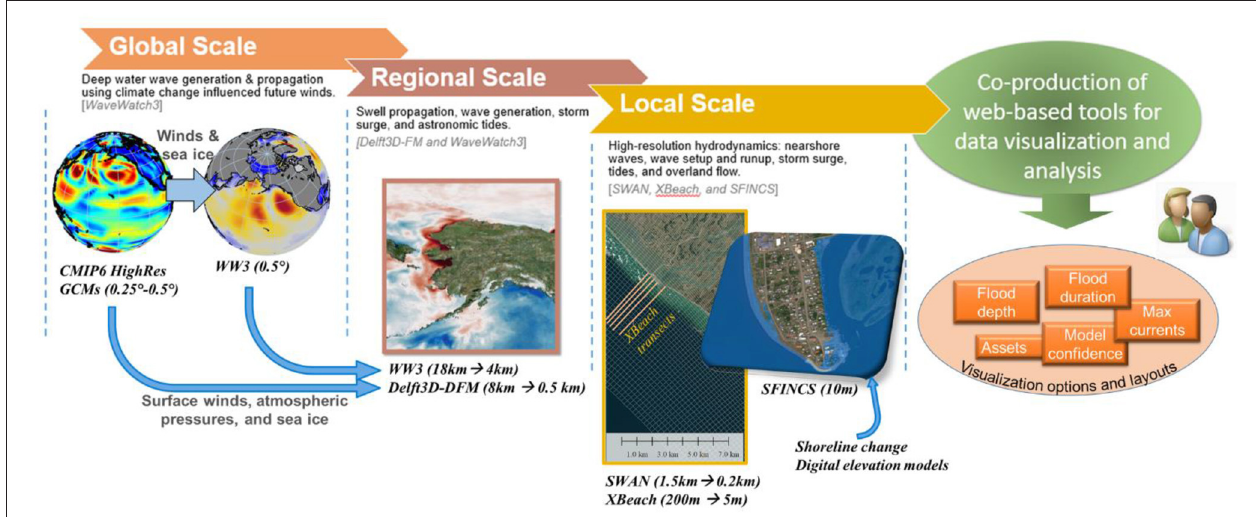
FIGURE 2 | Schematic overview of model system and development of hazard assessment products. The model train downscales projected atmosphere and sea ice fields from global climate models to regional and local scale oceanographic and flood hazards. At the local scale, historical long-term shoreline erosion is incorporated into the digital elevation models that are used to populate the overland flow models. In collaboration with stakeholders, model results are translated to digital tools aimed at assessing flood hazards and